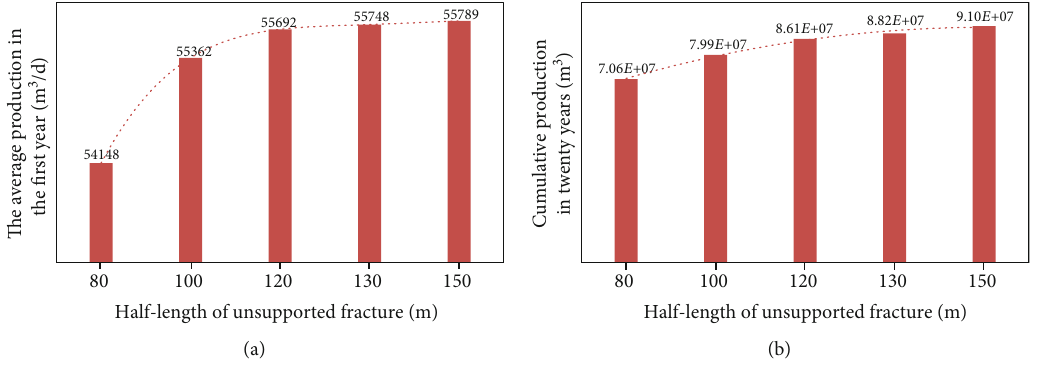
Figure 9: E ff ects of the half-length of unsupported fractures on gas production rate (a) and cumulative production (b).